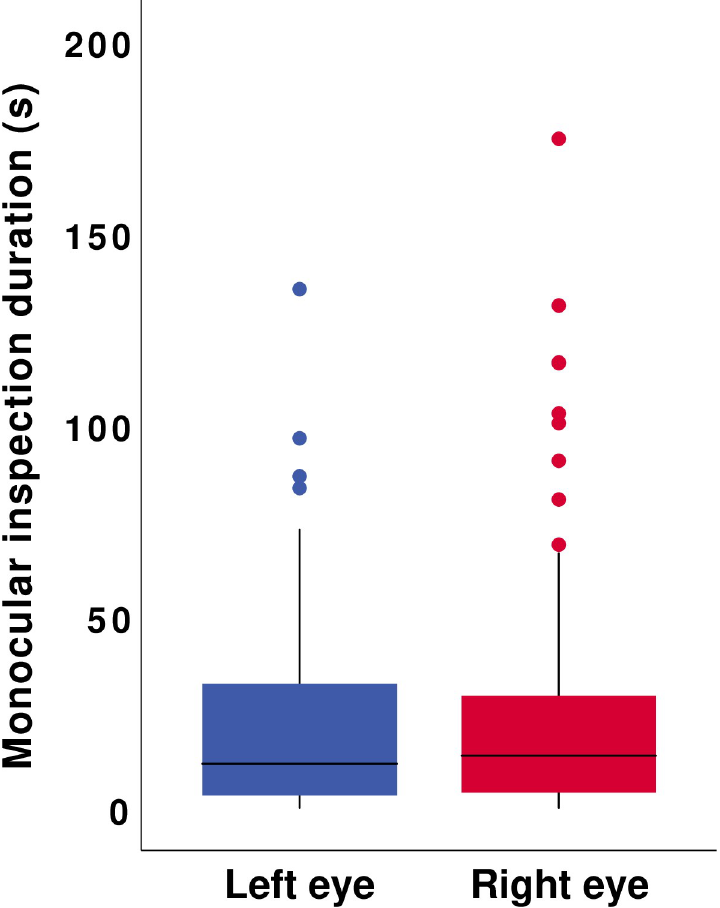
Fig 3. Time spent inspecting the inflated balloon stimulus using the left or right eye. Eye (left versus right) did not significantly predict the time spent in monocular inspection across horses (p =